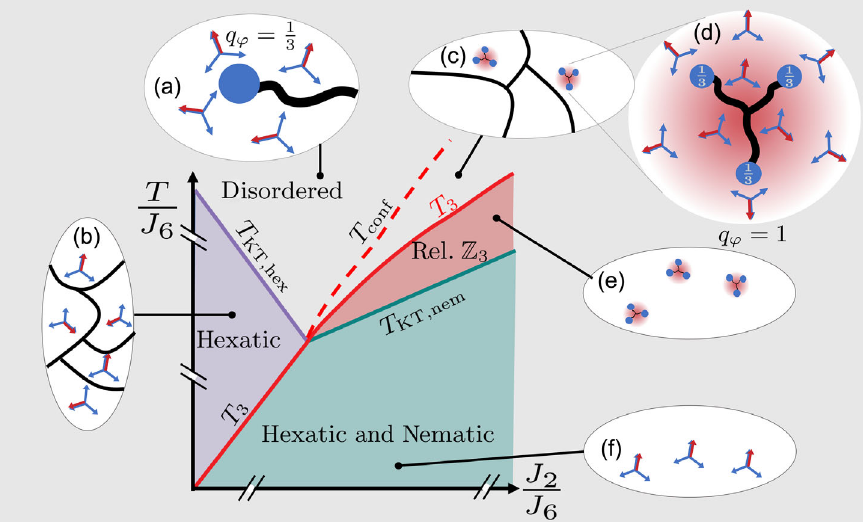
FIG. 1. Schematic phase diagram of the coupled XY model (2.1) (center); T and T are the binding temperatures of hexatic KT ; hex KT ; nem q 1 = 3 and nematic q 1 vortices, respectively. These are depicted as blue triarrows for the hexatic ϑ variable and as red arrows for ϑ ¼ φ ¼ the nematic φ variable. T 3 refers to a three-state Potts transition that is well established at temperatures below T , and we find they KT ; hex . The disordered phase is characterized by free hexatic vortices [ q ϑ ¼ 1 = 3 ; see blue dot in (a)], which also persist above T KT ; nem correspond to fractional nematic vortices attached to a Potts domain wall (in black depicted on the nematic variable here) where Δ n ¼ (cid:3) 1 . For J ≪ J T . The hexatic phase is shown in (b). The presence 2 6 , these hexatic vortices then bind in neutral pairs below KT ; hex of multiple Potts domains leads to disorder in φ (red arrows). Below T 3 a single Potts domain covers the whole system, and the absence of free vortices leads to order in the hexatic and nematic variables, as shown in (f). At larger J 2 =J 6 , a new sequence of phase transition develops. First, at T the q ϑ ¼ 1 = 3 defects undergo a confinement into composite q φ ¼ 1 vortices. In this confined phase (c), the conf absence of free q ϑ ¼ 1 = 3 defects and their associated “ dangling ” Potts domain walls leads to a network of local Potts domains. Within each domain, neither φ nor ϑ is ordered, and composite nematic vortices exist. An enlargement of one such vortex is shown in (d): The 1 . The core contains a structure where three q 1 = 3 vortices are bound by composite carries charge q φ ¼ 1 and q ϑ ¼ 3 × 1 ϑ ¼ 3 ¼ adjoining Potts domain walls. Below T 3 , the system develops a single Potts domain (e) containing free composite nematic